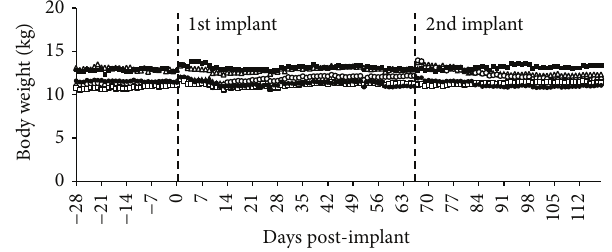
Figure 3: Individual body weights of study animals. Open markers indicate body weights of animals that did not receive pravastatin (UYL-0: open triangle, TSL-0: open circle, ORL-0: open square). Shaded markers indicate body weights of animals that did receive pravastatin (VPL-0: triangle, UDL-0: circle, UVL-0: square). ORL-0 and UVL-0 did not receive the second macrobead